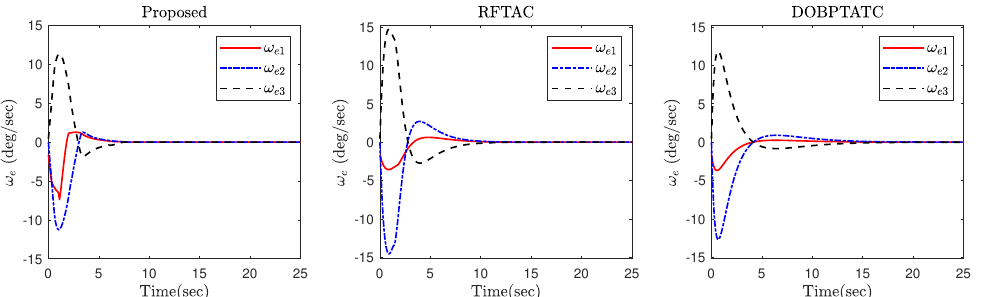
Figure 12. The attitude tracking error in Part 3.